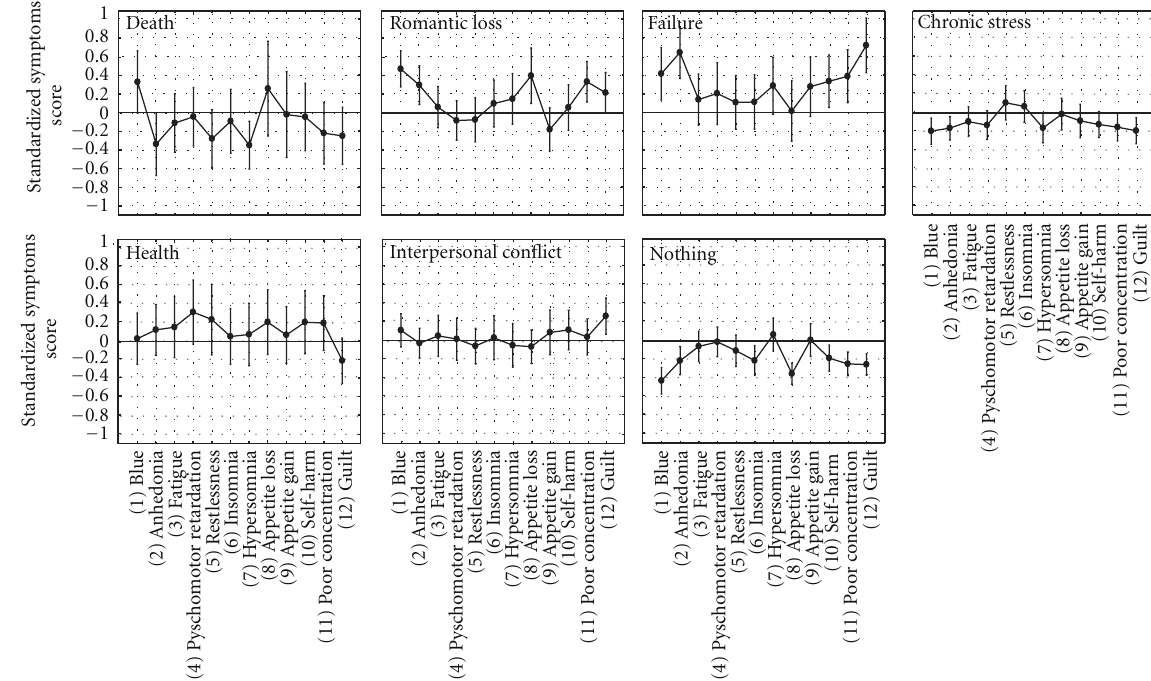
Figure 2: Profiles of average depressive symptom levels for the seven ALEs categories.